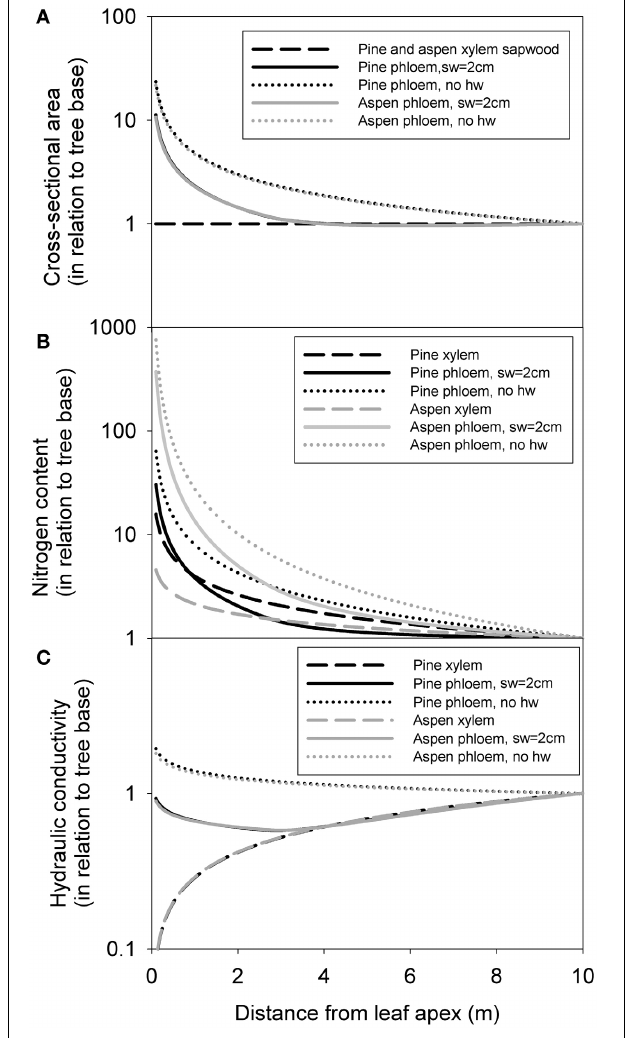
FIGURE 6 | The minimum and maximum xylem sapwood and phloem volume (A), nitrogen content (B) and conductance (C) in relation to a 10m tree obtained from the sensitivity analysis done with 1000 parameter combinations. Also total leaf nitrogen content is shown in (B) .